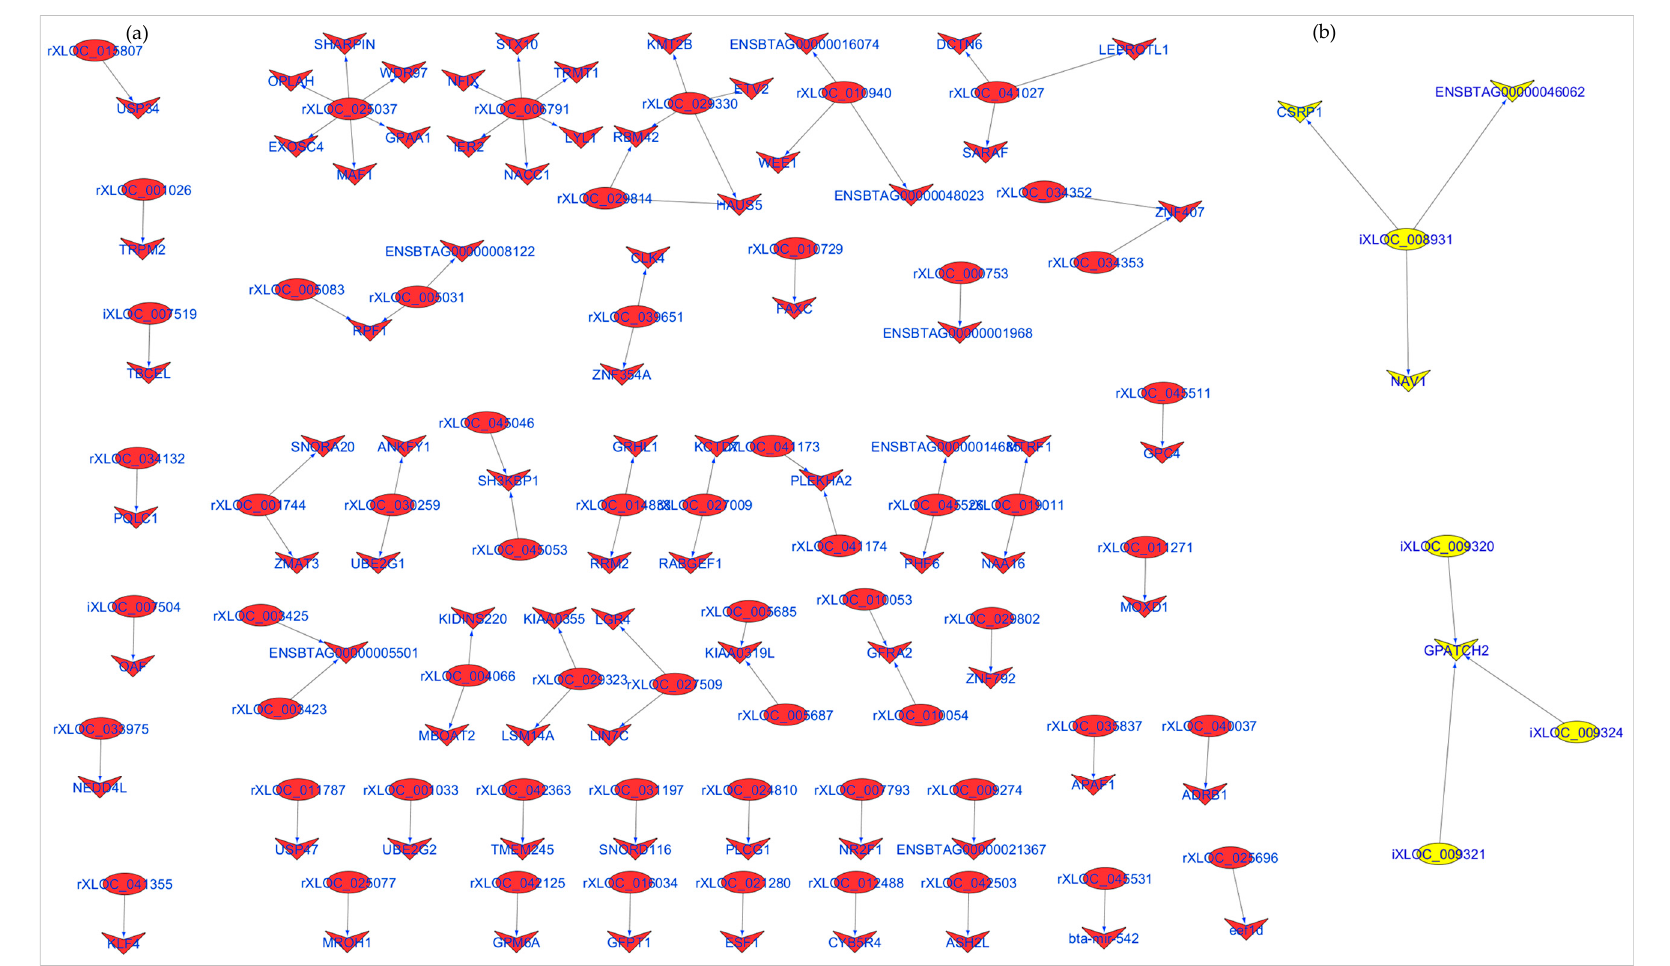
Figure 7. LncRNAs and their potential cis target genes in ( a ) rumen and ( b ) ileum tissues.